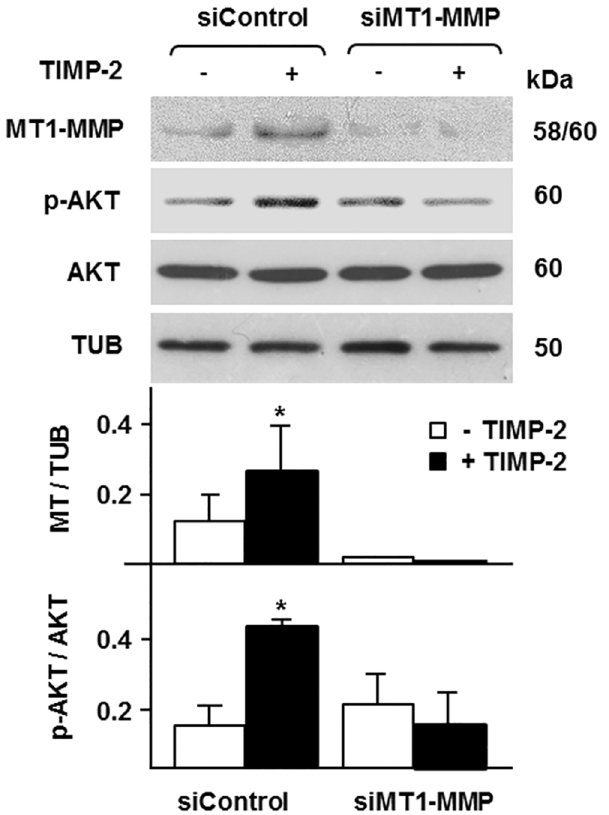
Fig 2. Downregulation of MT1-MMP blocks TIMP-2 activation of AKT in MT1-MMP expressing MDA-MB-435 cells. Western blotting analysis of AKT activation (p-AKT) and MT1-MMP expression in MDA-MB-435 cells transiently transfected with MT1-MMP siRNA (siMT1-MMP) or control, scrambled siRNA (siControl), and incubated with TIMP-2 (100 ng/ml) for 15 min. Total AKT and β -tubulin (TUB) are shown as loading controls. The lower panel shows the densitometric analysis of the MT1-MMP and p-AKT bands normalized to the corresponding TUB and AKT controls, respectively. * , p (cid:1) 0.05; + TIMP-2 vs . the corresponding – TIMP-2 sample. This experiment was repeated twice with comparable